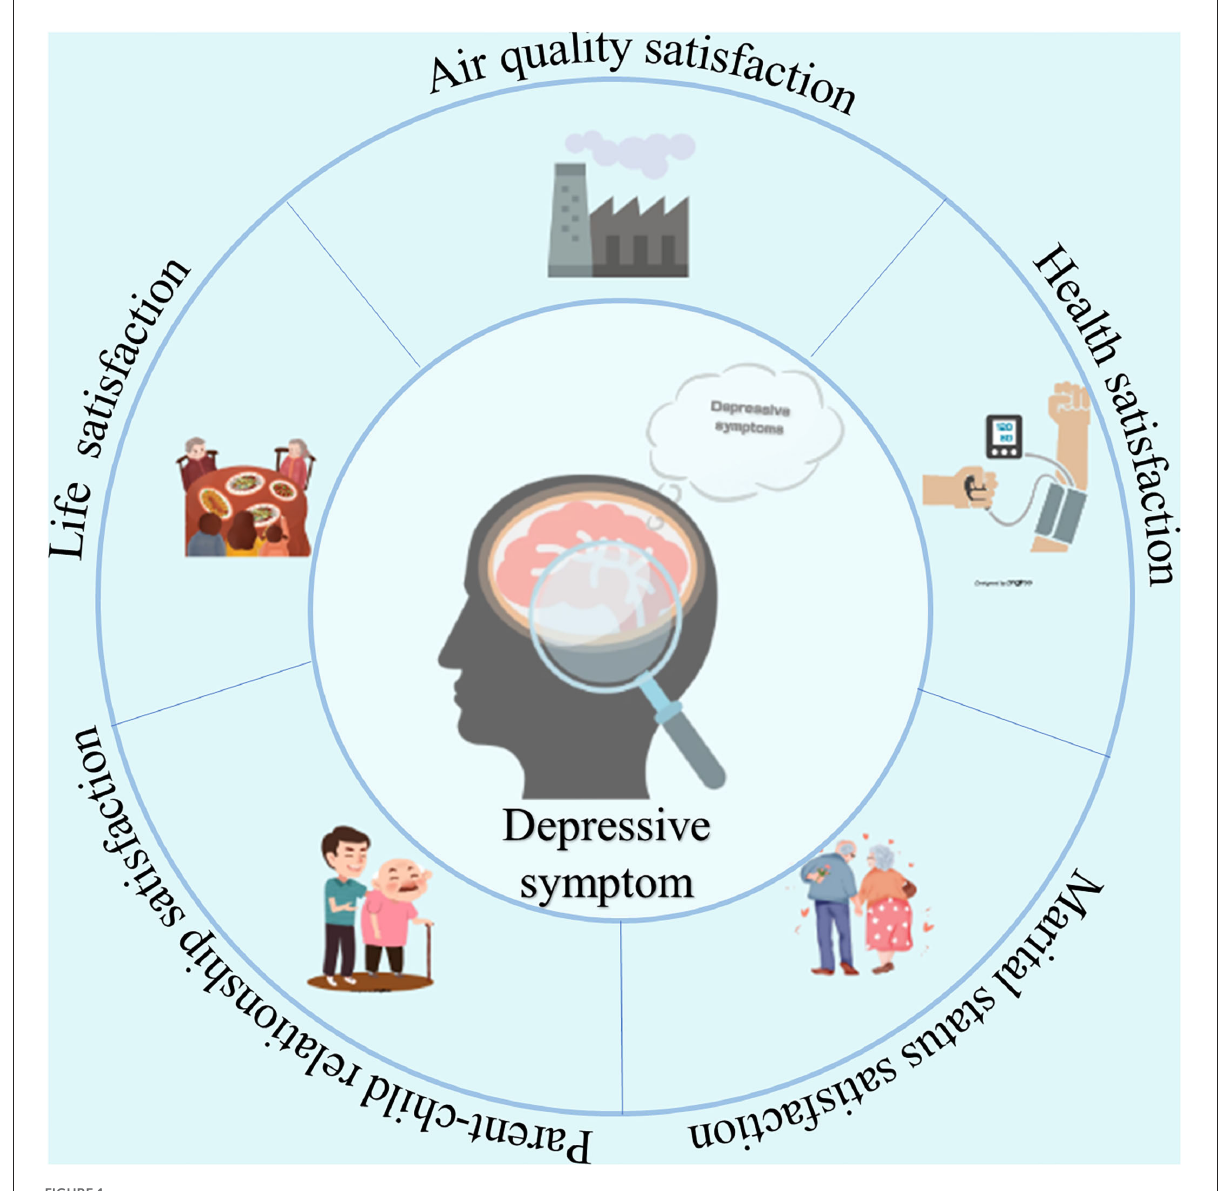
FIGURE1 The research hypothesis of the present study.